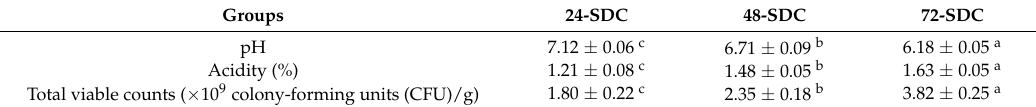
Table 2. The pH, acidity, and total viable counts of Shuidouchi (SDC) at different fermentation times. Groups